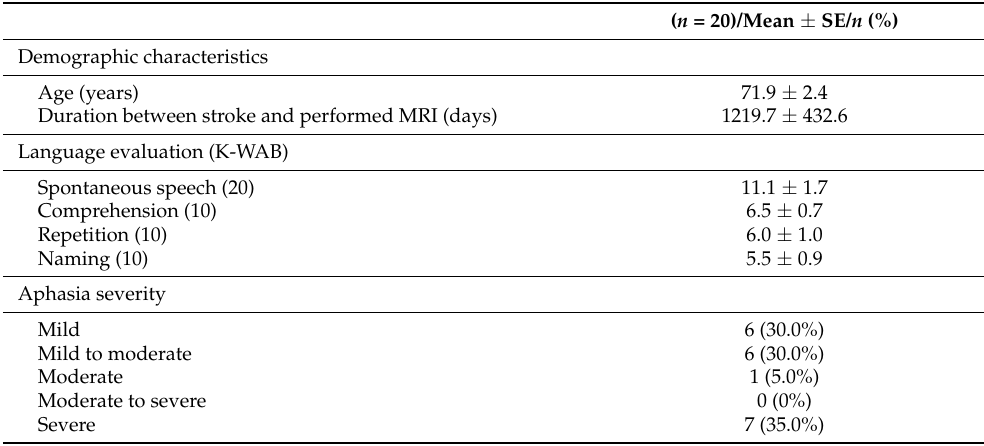
Table 2. Demographic characteristics and language function scores of patients included in the study.